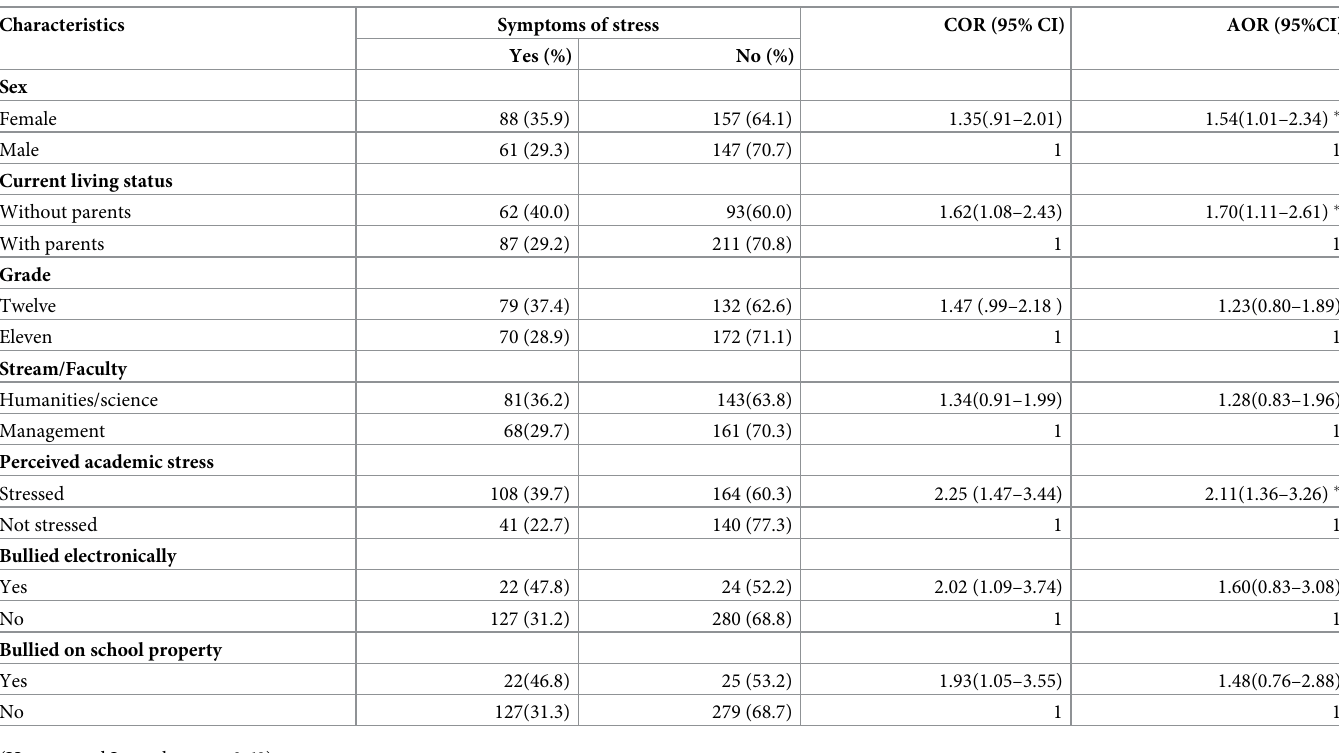
Table 6. Factors associated with symptoms of stress among the high school students of an urban municipality in Kathmandu (n = 453).